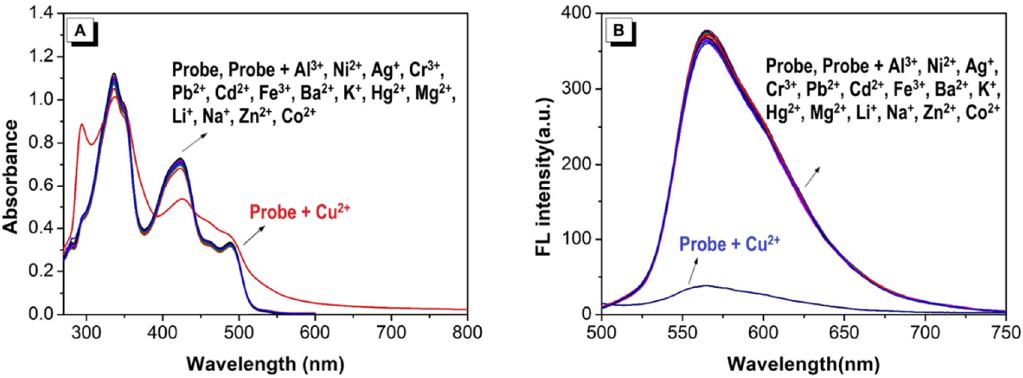
Figure 3. ( A ) The UV–vis and ( B ) Fluorescence spectra of the fluorescence probe L interacting with different metal ions (λ ex /λ em = 428/565 nm, slit: 5/5 nm, voltage: 900 v).